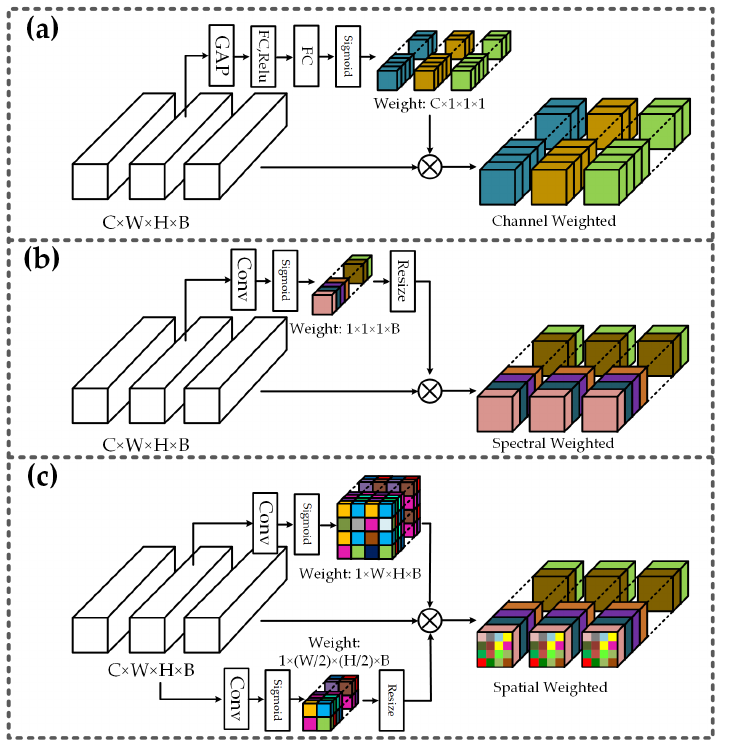
Figure 1. Various attention modules, including ( a ) channel-wise attention, ( b ) spectral-wise attention and ( c ) spatial-wise attention. C , W , H and B represent the number of channels, width, height and number of bands respectively. For easier understanding, weighted channels, weighted bands, and weighted pixels are represented by different colors. GAP denotes the global average pooling and FC denotes the fully connected layer. Conv represents the convolutional